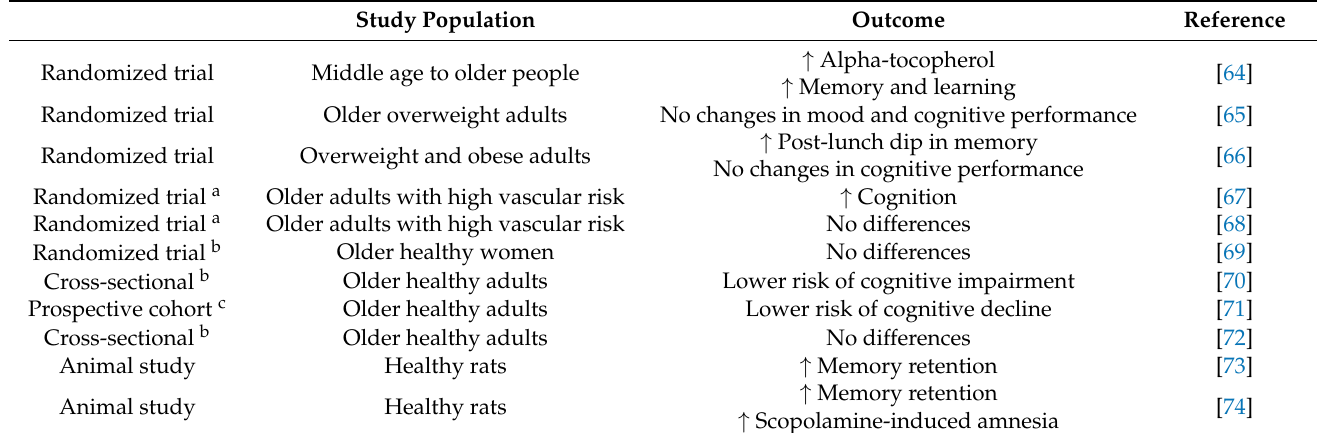
Table 6. Cognitive performance related to almond